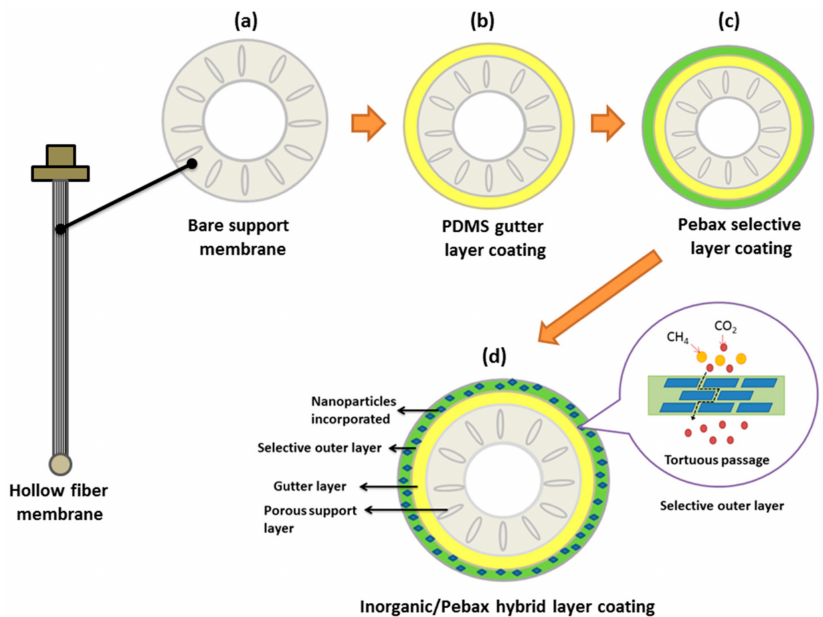
Figure 1. Illustration of the hybrid coating approach for the fabrication of multilayered hollow fiber membrane (potted in a module), ( a ) uncoated membrane, ( b ) PDMS-coated membrane, ( c ) Pebax-coated membrane, and ( d ) multilayer hybrid-coated